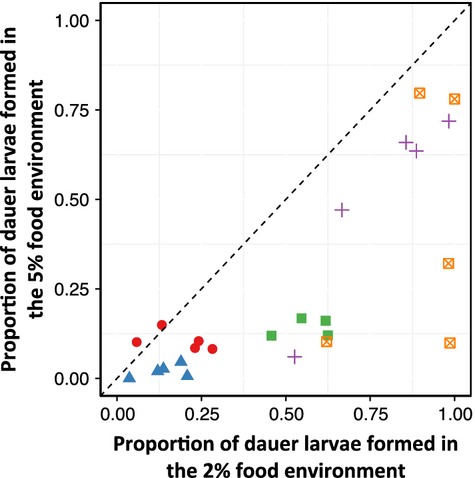
The correlation of dauer larva formation by selected and control lines tested in 2% and 5% w/v food environments, where each dot is the mean value for each inbred line from across three replicates, and where the symbols and colours differentiate the four different selection regimes (blue = 2% food, green = 5% food, violet = 2% food & ascr#2, and orange = 5% food & ascr#2) and the unselected, control population (red).